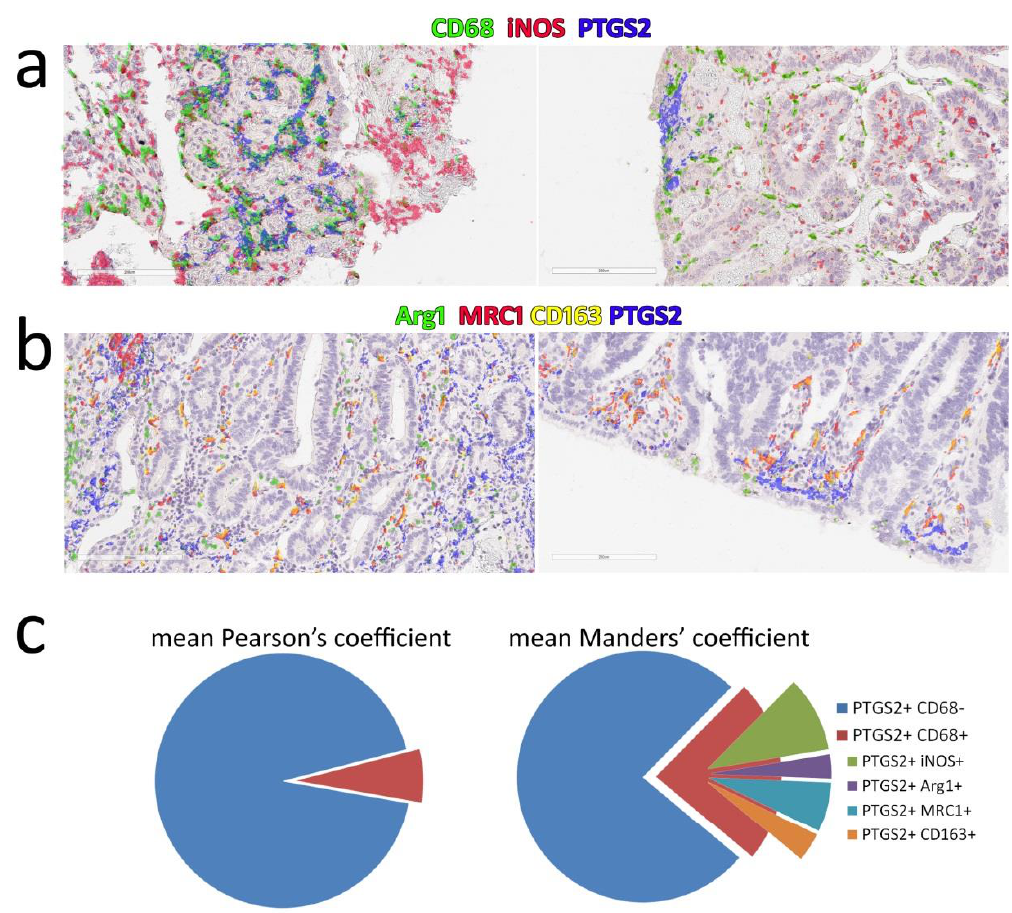
Figure 4. Multiplex IHC analysis of PTGS2 co-localization with macrophage markers CD68, iNOS, Arg1, MRC1 / CD206, and CD163: ( a ) two examples of co-localization signals in the M1 series (CD68–iNOS–PTGS2), pseudocolors have been obtained overlaying the black&white mask of each marker on the first slide of the series; ( b ) two examples of co-localization signals in the M2 series (Arg1–MRC1–CD163–PTGS2); ( c ) left, mean Pearson’s coe ffi cients of PTGS2 and CD68 co-localization; right: a simplified representation of the mean overlay between PTGS2 and each marker using Manders’ overlap coe ffi cients. Slices indicate the extent of PTGS2 signal in the positive areas of each marker (complete analysis is shown in Supplementary Figure